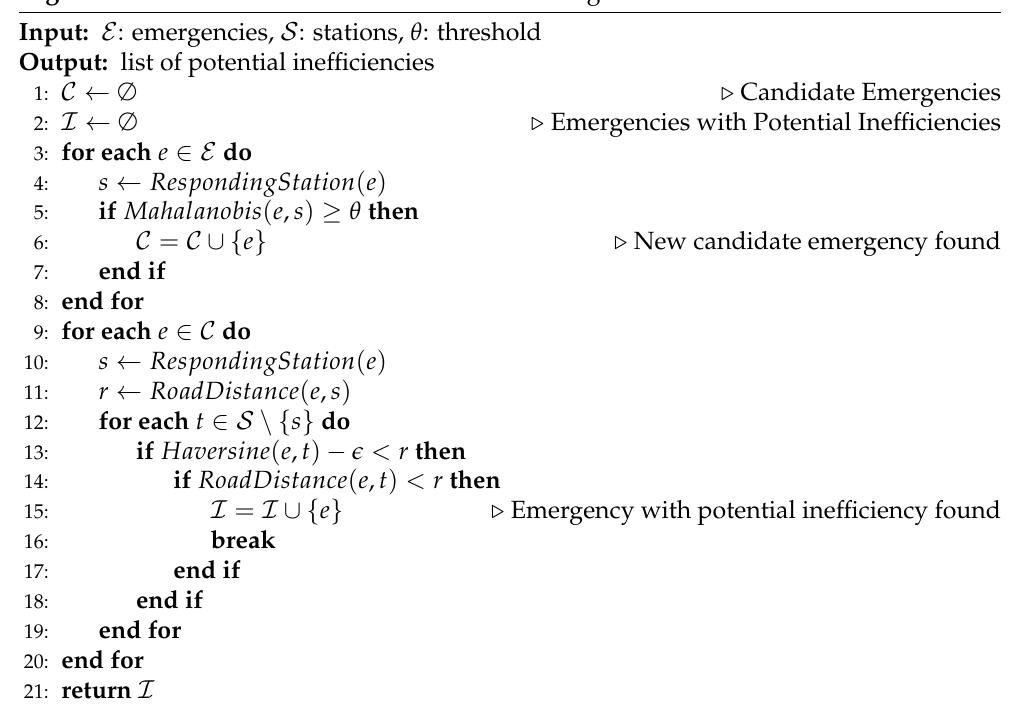
Algorithm 1 Potential inefficiencies identification